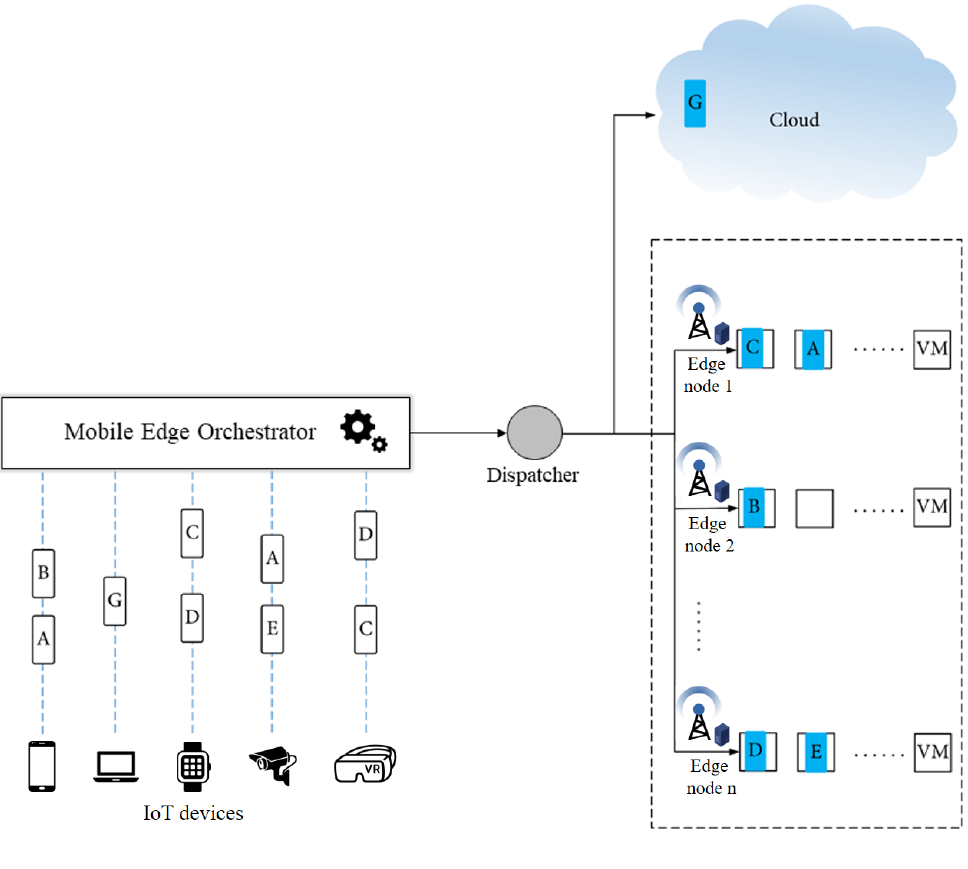
Figure 1. The flow of offloaded tasks through a mobile edge